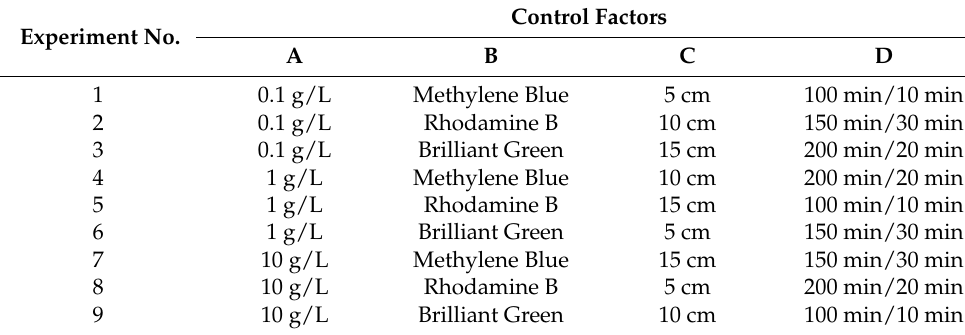
Table 2. Modified L9 orthogonal